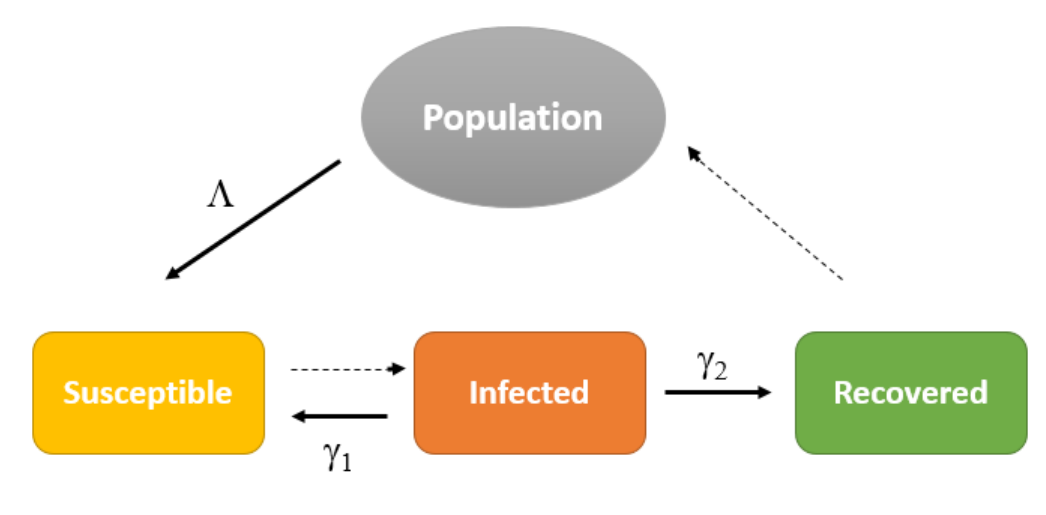
Figure 1. SIRS model